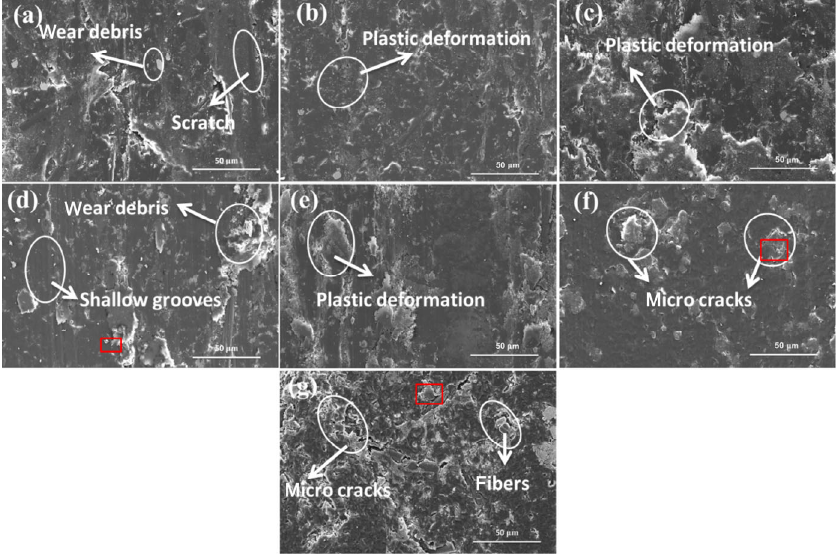
Fig. 4 SEM images of the worn surfaces at (a) RT, (b) 50 °C, (c) 100 °C, (d) 200 °C, (e) 250 °C, (f) 300 °C, and (g) 350